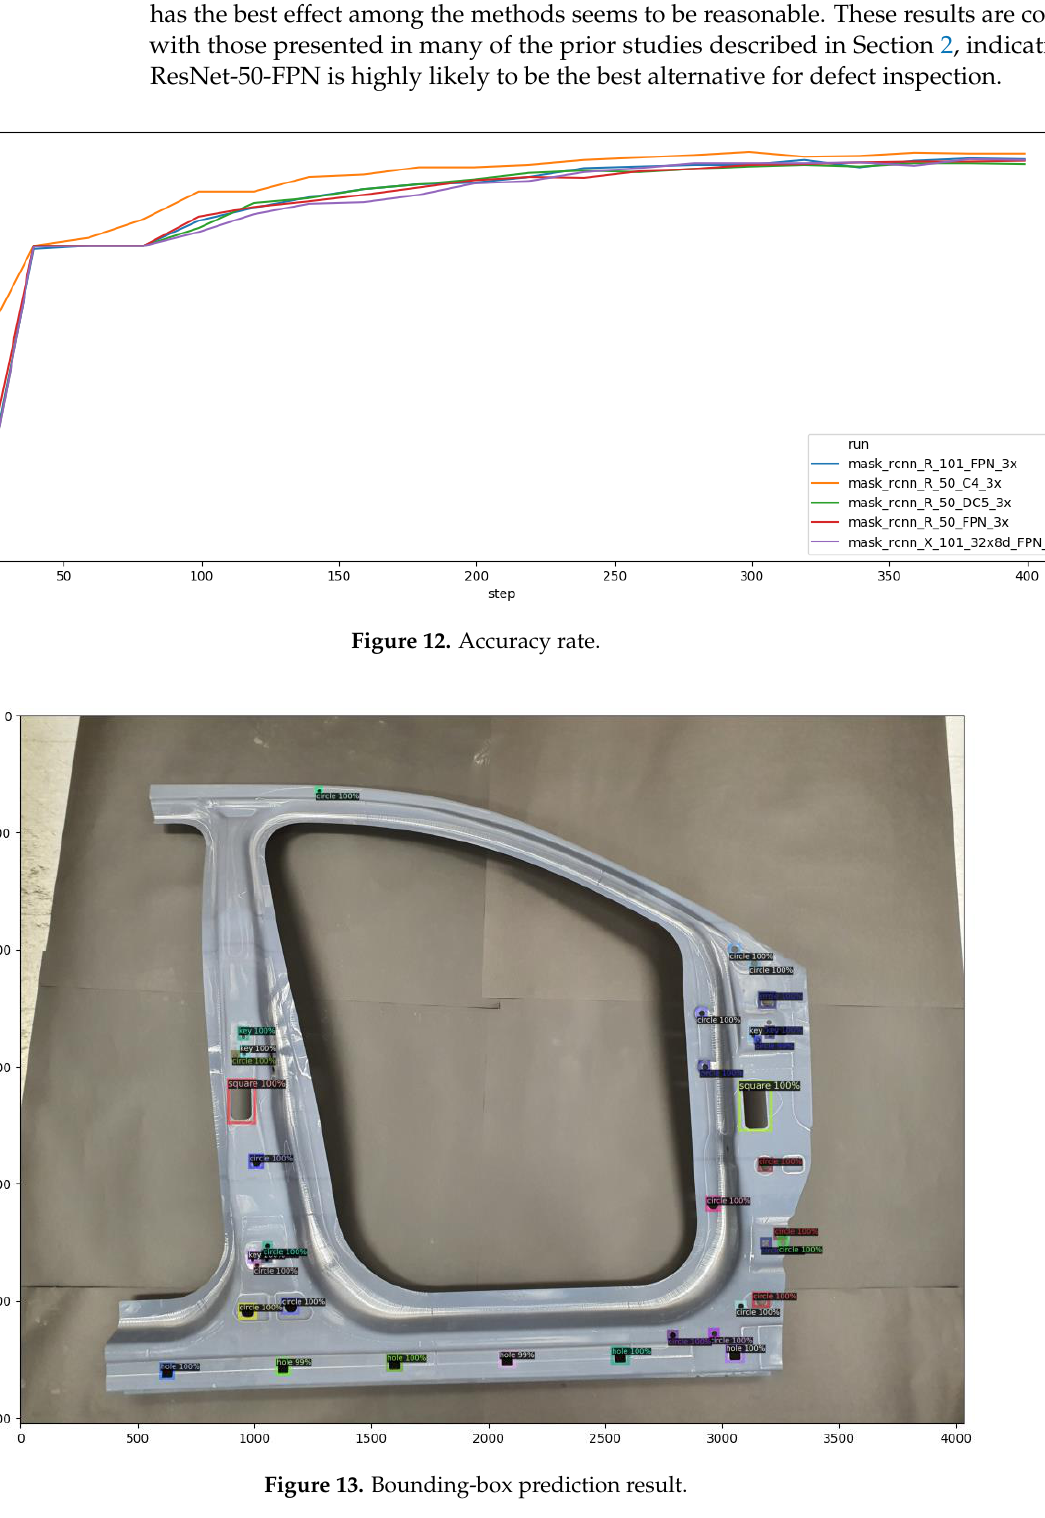
Figure 11. Loss rate.